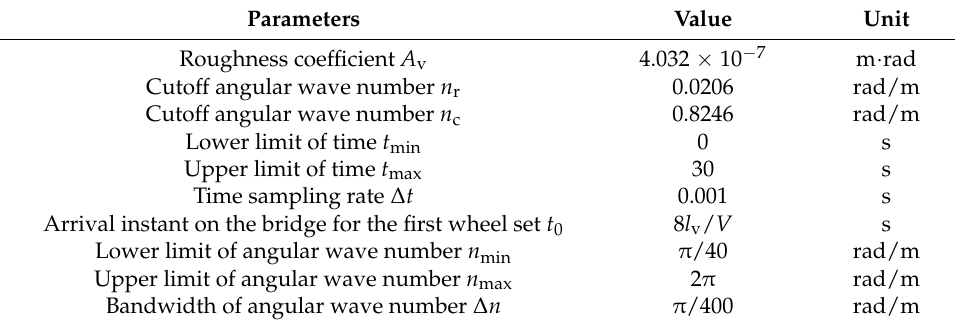
Table 3. Parameters of vertical track